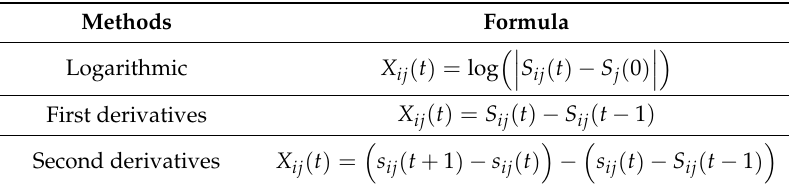
Table 4. Methods of data preprocessing for data